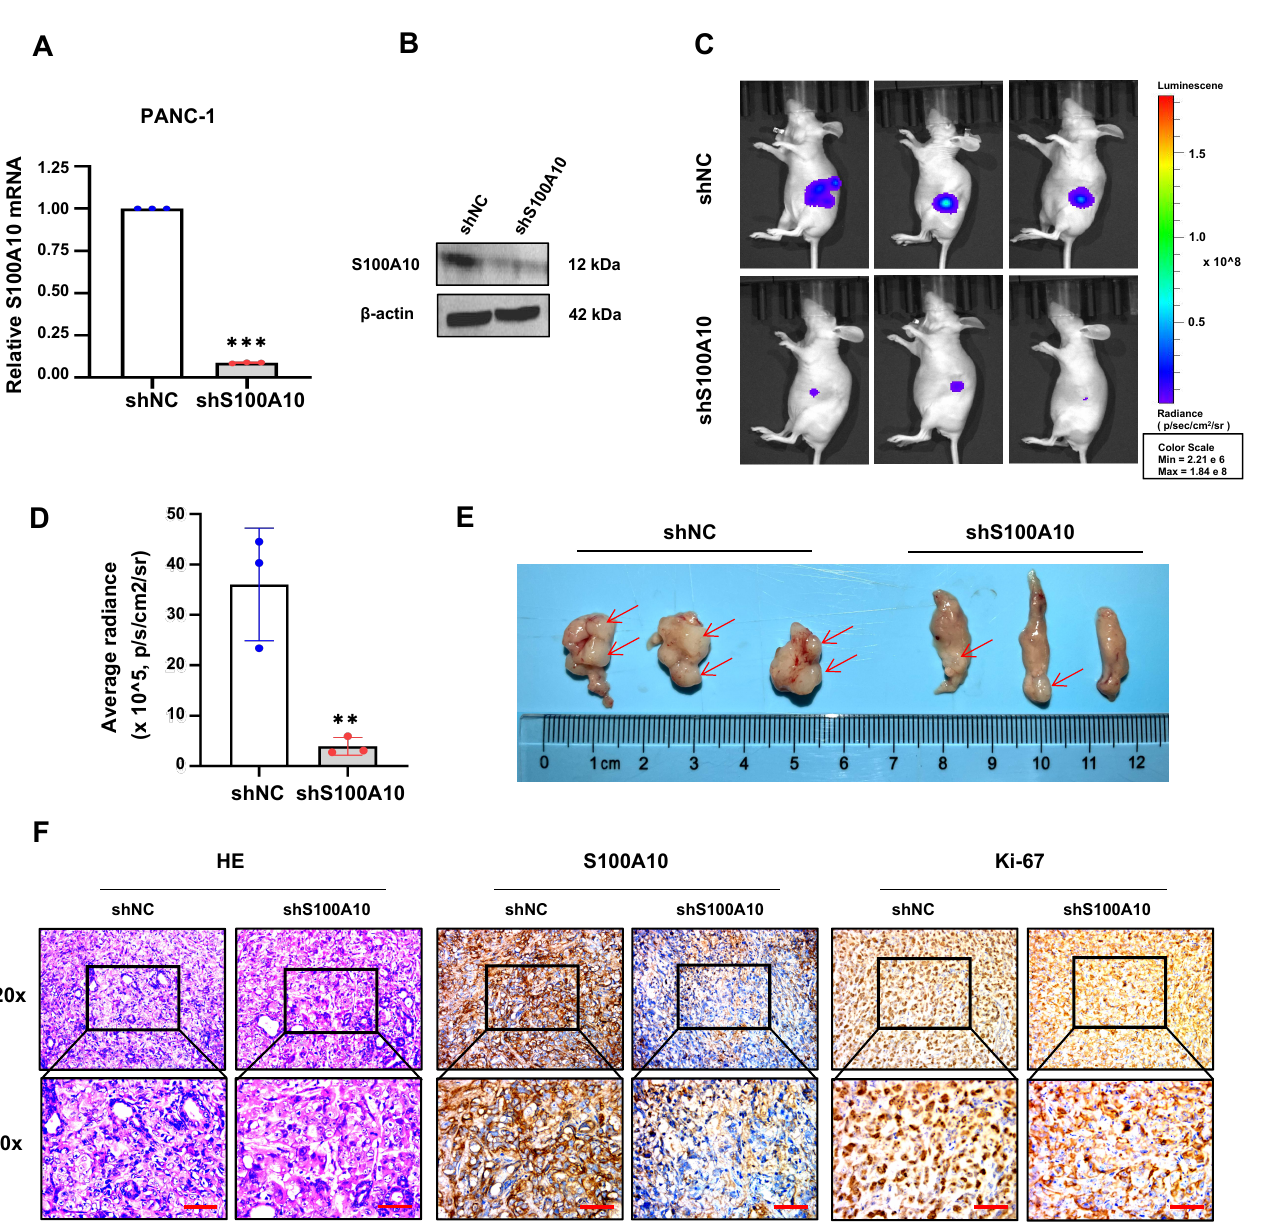
Figure 3. S100A10 knockdown inhibits pancreatic tumor growth in vivo. ( A , B ) RT-qPCR and Western blotting were used to measure the expression of S100A10 in the control (shNC) and S100A10 stably knocked-down (shS100A10) PANC-1 cells. ( C , D ) Luciferase images from shNC and shS100A10 PANC-1 cells orthotopic xenograft mice ( n = 3). Luciferase images represent one picture captured and the values of average radiance are represented as mean ± SEM of the indicated number of mice. ( E ) Tumor size in shNC and shS100A10 PANC-1 cells orthotopic xenograft mice ( n = 3). ( F ) HE stain and IHC stain of S100A10/Ki-67 in shNC and shS100A10 PANC-1 cells pancreatic tumor tissues. Scale bar: 50 um. Values represent mean ± SD ( n = 3). ** p < 0.01 and *** p < 0.001 by Student’s t -test. Whole western blot images are showed in Figure